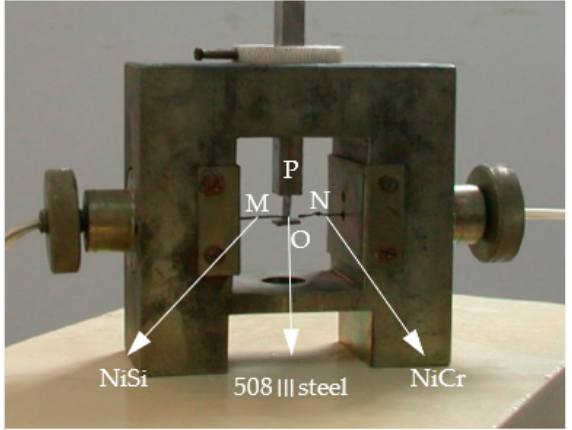
Figure 3. Device diagram of thermocouple indexing calibration.